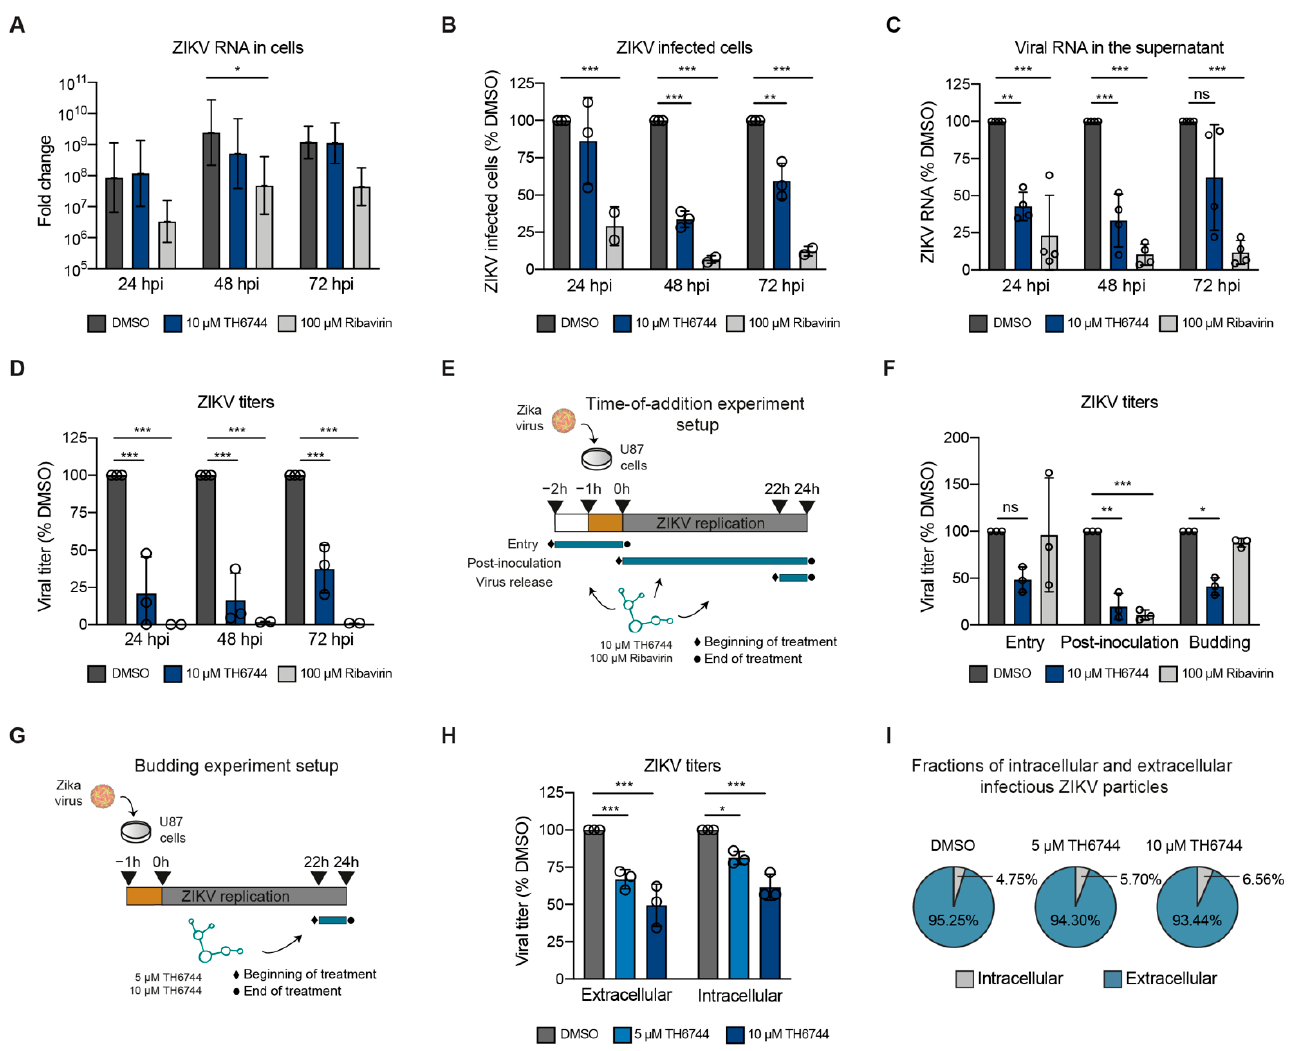
Figure 4. TH6744 disturbs late replication cycle steps in ZIKV life cycle. ( A – D ) U87 cells were infected with ZIKV (MOI 1) and treated with indicated compounds for 24, 48 or 72 h. ( A ) ZIKV RNA levels inside the cells were quantified by qPCR. ( B ) Number of ZIKV-infected cells was quantified by virus infectivity assay. ( C ) ZIKV RNA levels in the supernatant were quantified by one-step qRT-PCR. ( D ) ZIKV titers were quantified by end-point dilution assay. ( E ) Schematic overview of time-of-addition experimental setup in U87 cells. ( F ) U87 cells were infected with ZIKV (MOI 10) for a total of 24 h and treated with DMSO control, 10 μ M TH6744 or 100 μ M Ribavirin for indicated periods during early (entry), late (budding) or throughout replication cycle (post-inoculation). ZIKV titers were quantified by end-point dilution assay. ( G ) Schematic overview of budding experimental setup. ( H ) U87 cells were infected with ZIKV (MOI 10) for 22 h and treated with indi- cated TH6744 doses for 2 h. Intracellular ZIKV particles were obtained by mechanical cell lysis and extracellular ZIKV particles from the supernatants and both were quantified by end-point dilution assay. ( I ) Average fractions of intracellular and extracellular infectious ZIKV particles of the total particles quantified in ( H ). ( A – D , F , H ) Data are expressed as a mean ± SD from at least n = 3 biological replicates. Statistical significance was determined by using one-way ANOVA with Dunnett’s multiple comparison analysis. * p < 0.05, ** p < 0.01, *** p < 0.001. A time-of-addition study was performed in U87 cells in order to further understand which virus life cycle step is influenced by TH6744 (Figure 4E). When the cells were pre- treated with TH6744 for 1 h and at viral entry during viral inoculation and thereby al- lowed to replicate for 24 h, a 50% reduction on viral titer was observed, while Ribavirin had no effect on the entry steps (Figures 4F and S5C). When adding TH6744 directly after virus inoculation for 24 h (post-inoculation), a pronounced reduction of viral titer was observed (Figure 4F). Interestingly, when TH6744 treatment was initiated at 22 h after